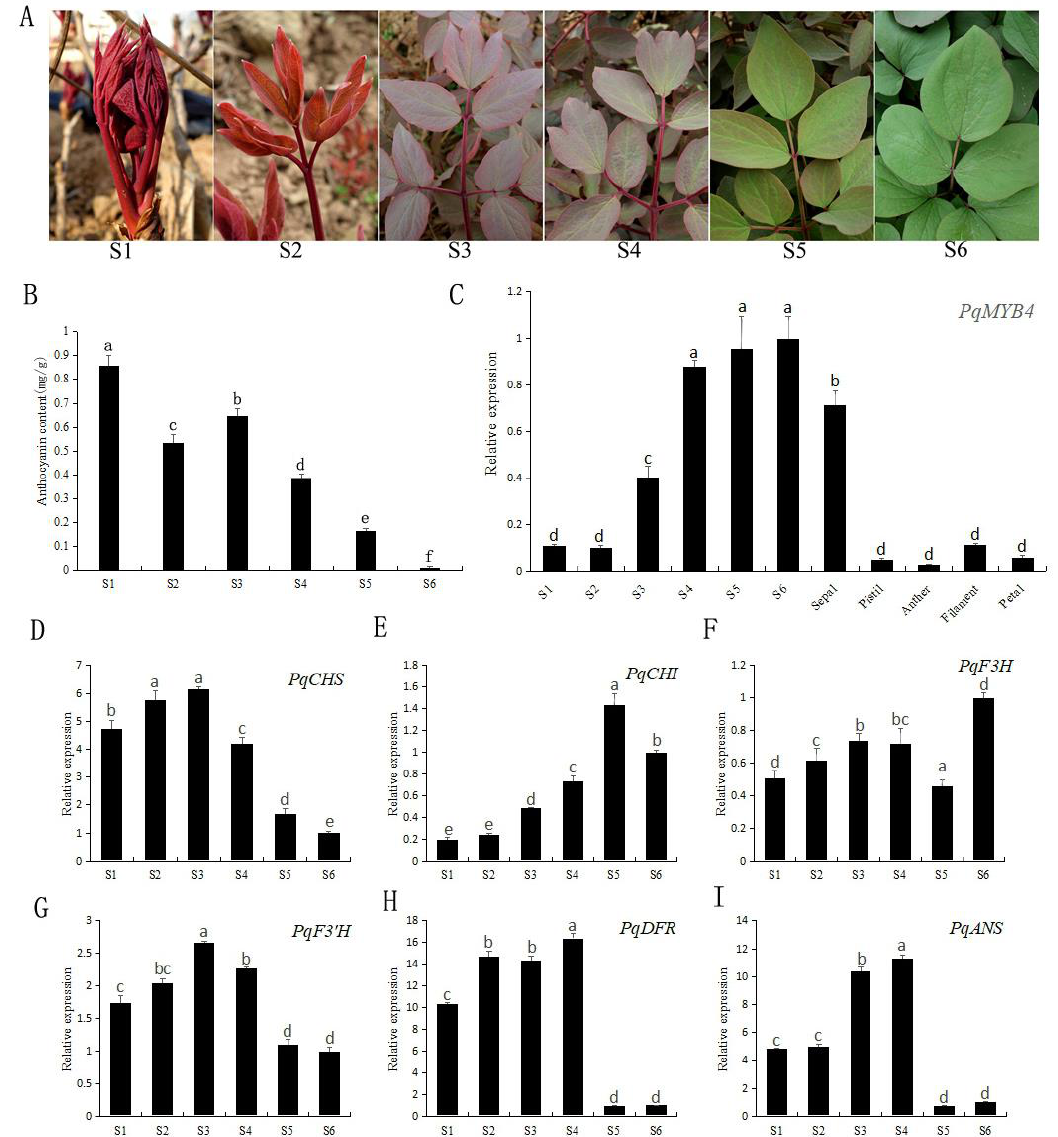
Figure 6. Anthocyanin content, expression levels of PqMYB4 and anthocyanin biosynthetic genes in different leaf color stages in P. qiui . ( A ) the leaf phenotype of P. qiui in different leaf color stages. S1: germination stage with red color, S2: sprout leaves stage with light red color, S3: red stage, S4: red with green stage, S5: green with red stage, S6: green stage; ( B ) anthocyanin content; ( C ) the expression level of PqMYB4 ; ( D – I ) the expression level of anthocyanin-related biosynthetic genes, PqCHS ( D ), PqCHI ( E ), PqF3H ( F ), PqF3’H ( G ), PqDFR ( H ), PqANS ( I ). a, b, c, d, e and f indicate significant difference at p ≤ 0.05 level by Duncan test.